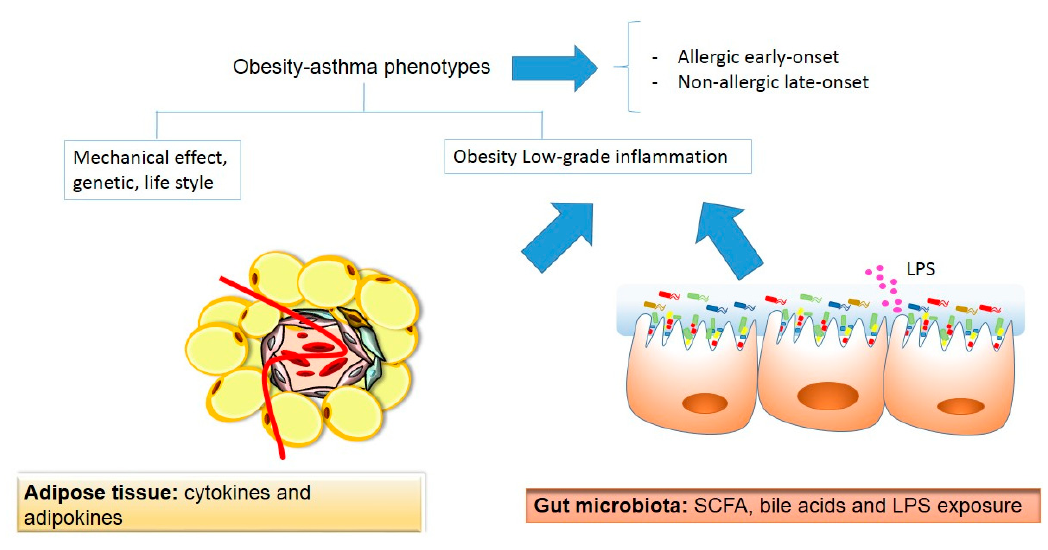
Figure 2. A schematic representation of the potential linking mechanisms between obesity and asthma. SCFAs: short-chain fatty acids; LPS: lipopolysaccharide. Beige color indicates adipose tissue origin, whereas the pink color indicates gut microbiota origin.